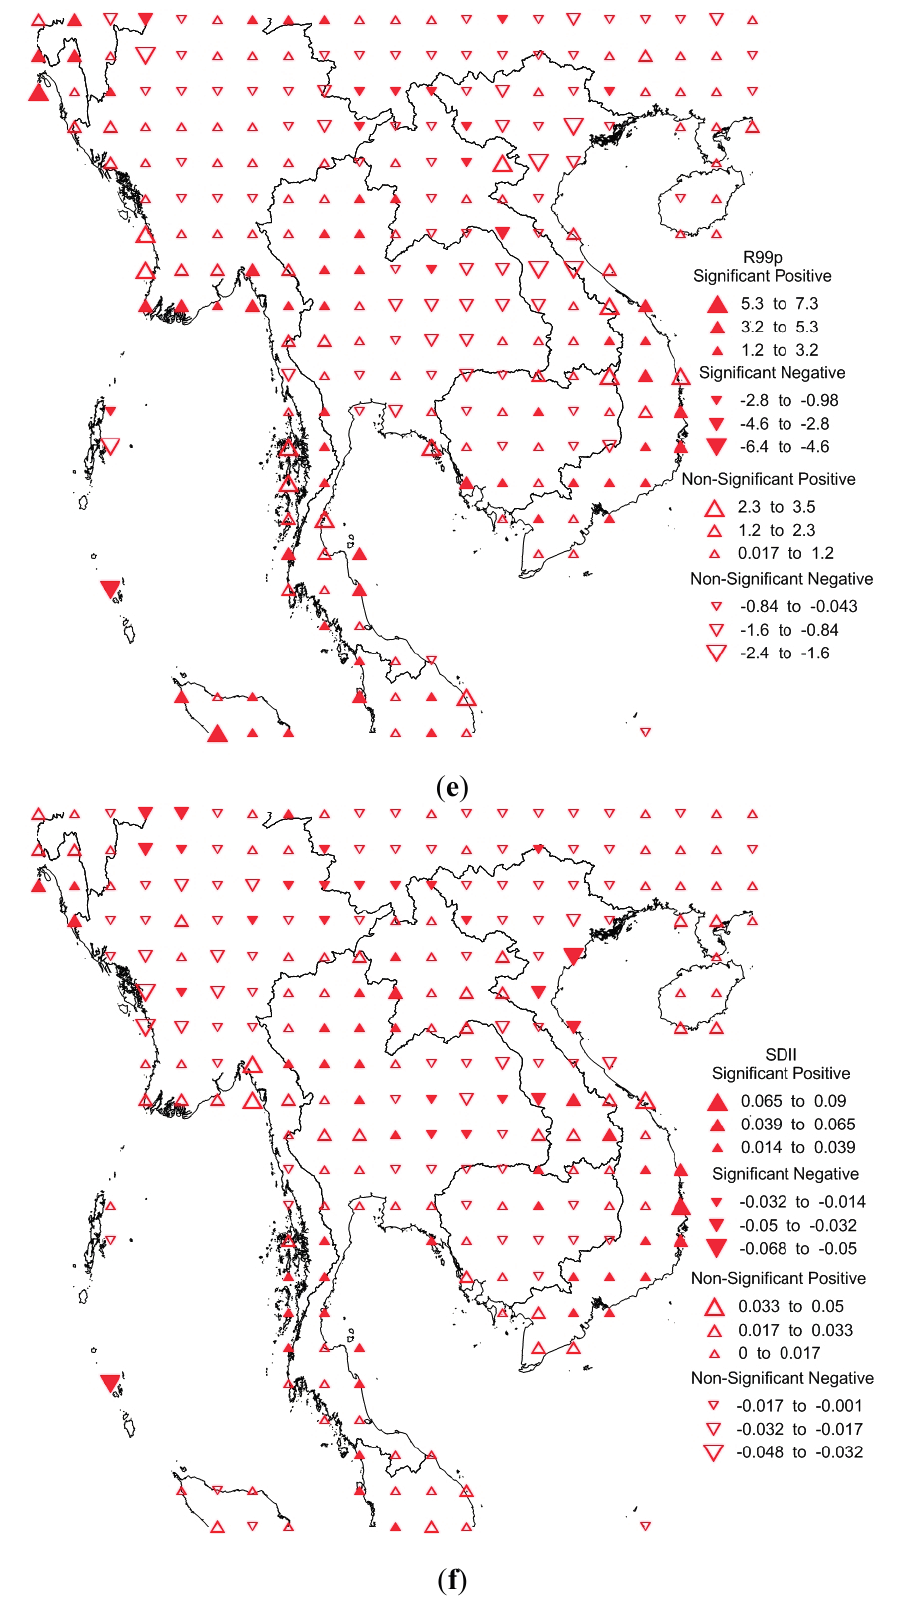
Figure 17. The point pattern analysis of intensity indices of extreme rainfall over the Indochina Peninsula. ( a ) RX1day; ( b ) RX5day; ( c ) PRCPTOT; ( d ) R95p; ( e ) R99p; ( f )